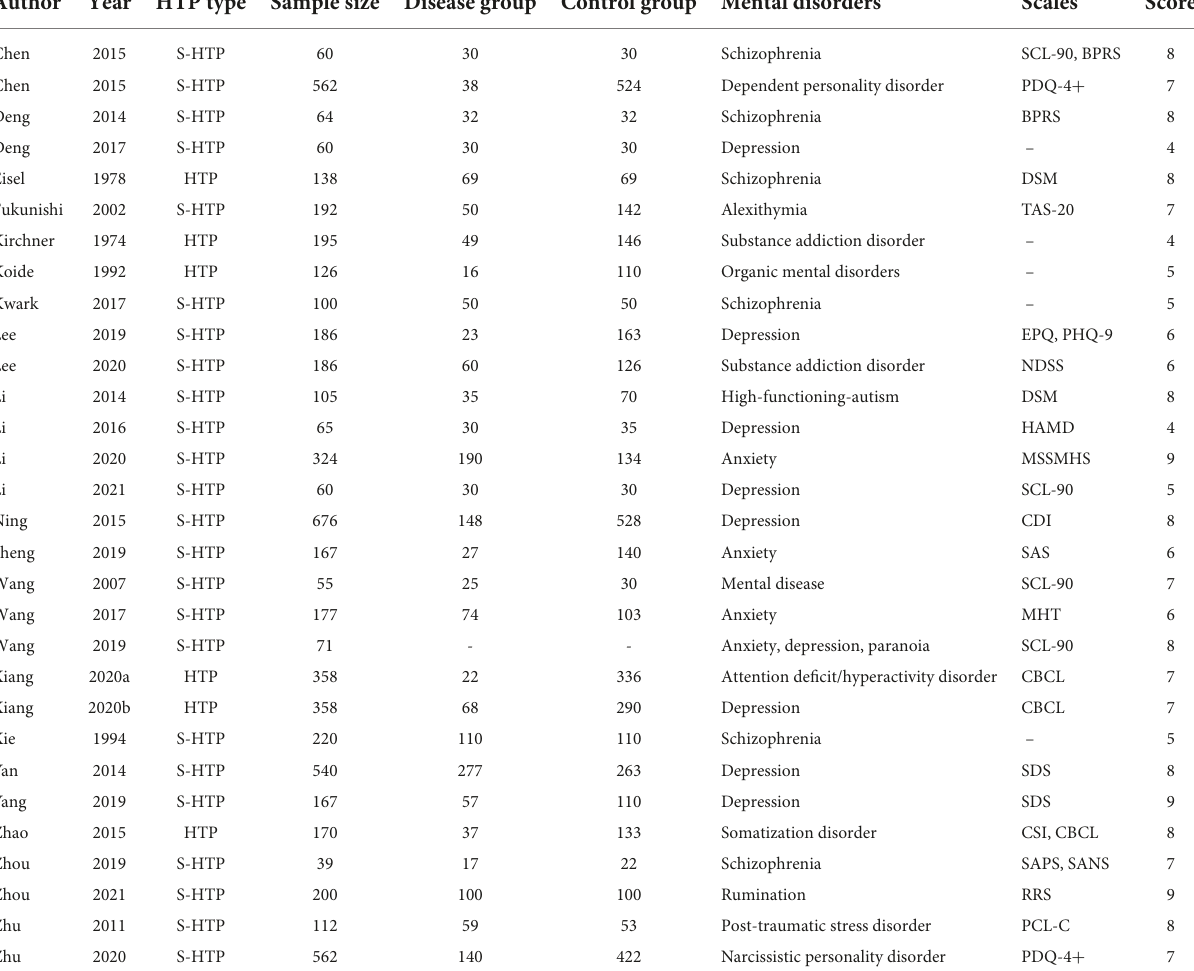
TABLE 1 Studies included in the